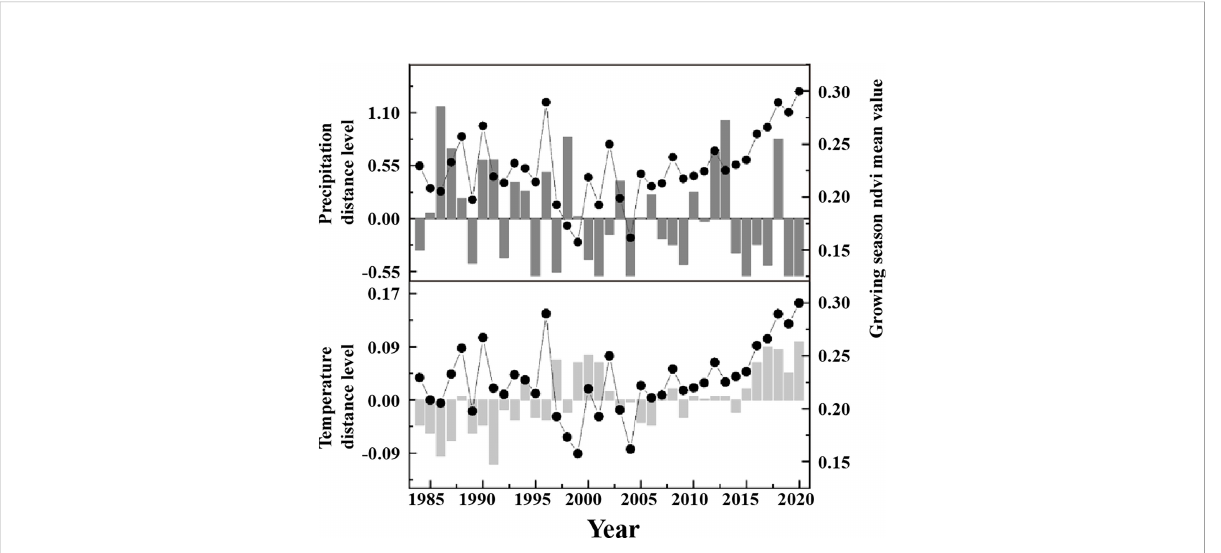
FIGURE 5 The interannual variations of NDVI, precipitation and temperature in June of 1984-2020.